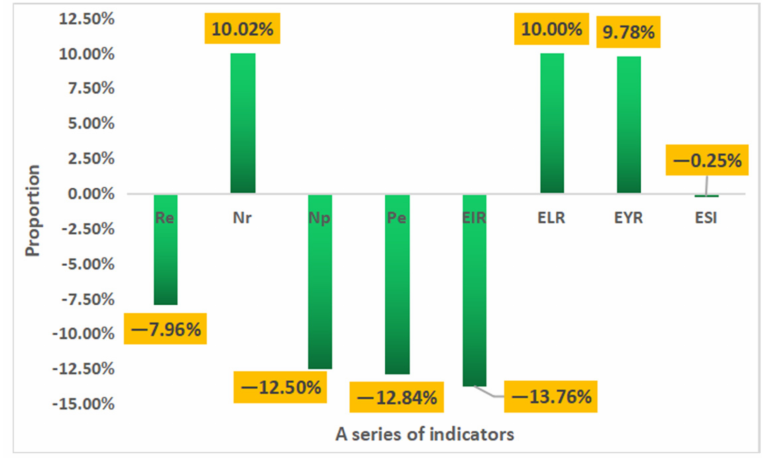
Figure 12. The variation range of key indicators based on a 10% reduction. Figures 13 and 14 detail variation ranges of key indicators based on the 5% increment hypothesis. The absolute values of changes from largest to smallest are Re ( − 7.08%), ELR (5%), Nr (4.98%), EYR (4.89%), Np ( − 3.57%), Pe ( − 2.75%), EIR ( − 2.75%) and ESI ( − 0.1%), respectively. ESI hardly changes and also verifies the building system stability.